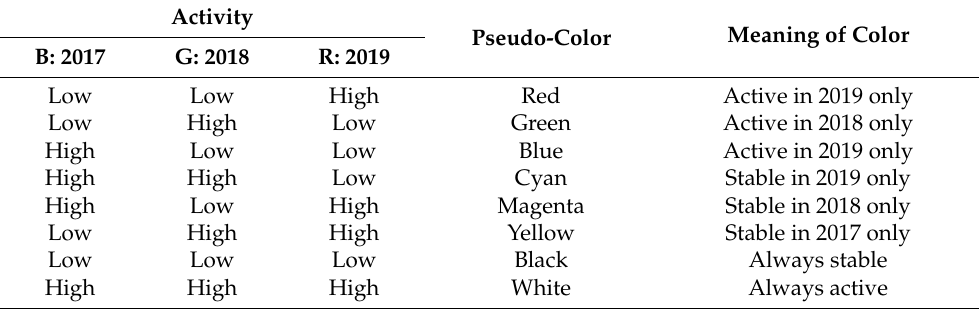
Magenta Stable in 2018